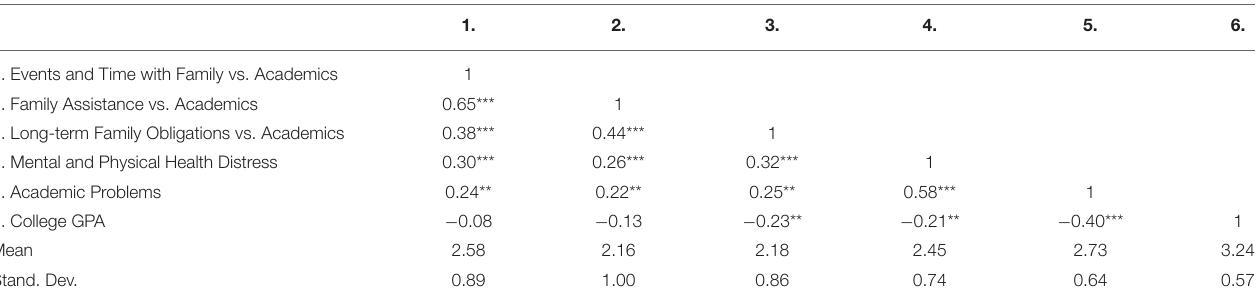
TABLE 2 | Zero-order Correlations for Variables of Interest in Models Assessing Consequences of Home-School Cultural Value